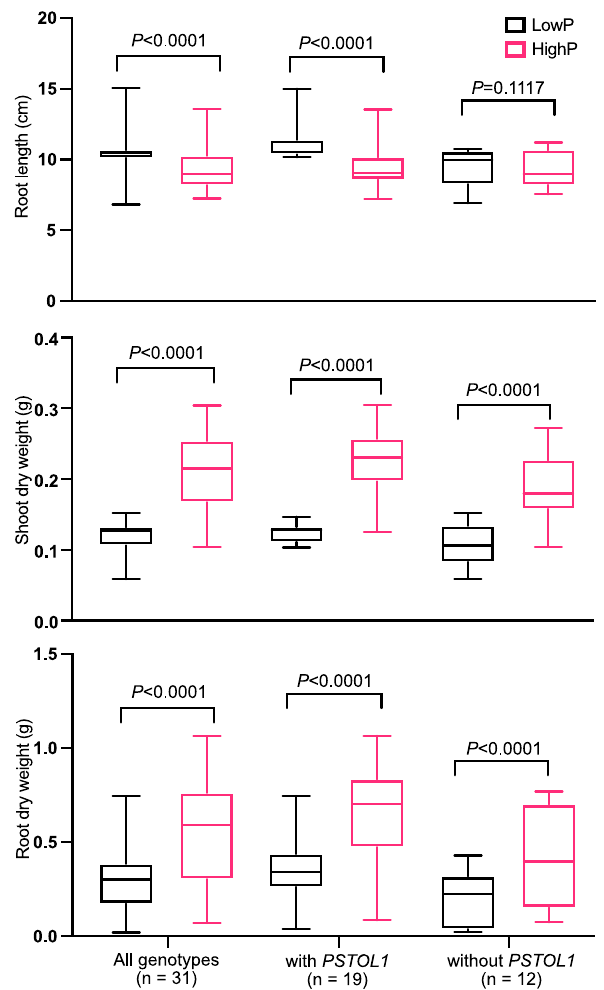
Figure 4. Performance of rice genotypes under two phosphorus conditions for three different growth traits. The figure was edited for presentation using Affinity Designer 1.9.3 (https:// affin ity. serif. com/ en-